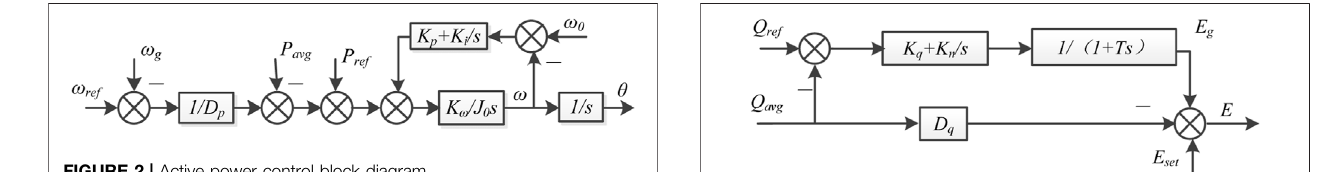
FIGURE 2 | Active power control block diagram.